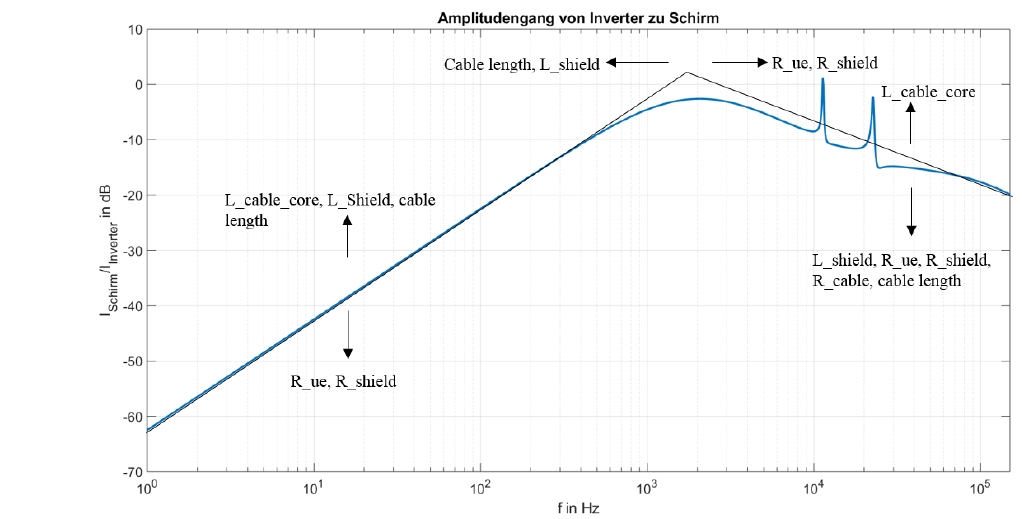
Figure 11. Qualitative effect of parameter changes on the transfer function from inverter ripple current to shield